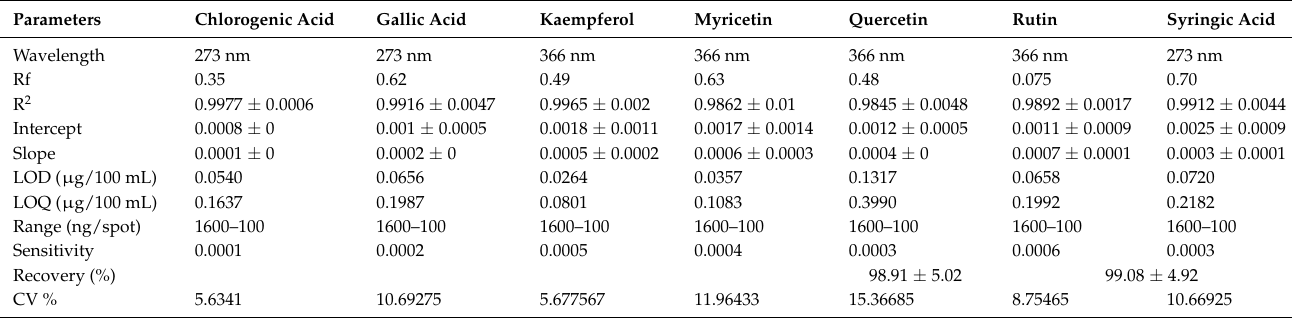
Table 2. Validation data for HPTLC analysis.